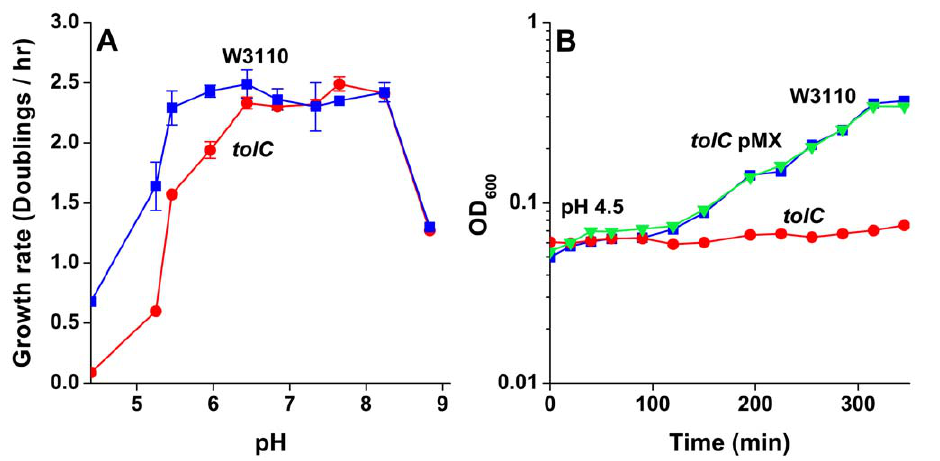
Figure 4. TolC is required for acid growth. A ) Strains were grown from pH 4.5–pH 9.0 using the appropriate buffer in half unit increments at 37 u C. W3110 (blue) and tolC :: kan (red) growth rates calculated in early log-phase (OD 600 0.1 to 0.3) are depicted as a function of pH. B ) Successful complementation of the tolC strain with pMX, a low-copy plasmid that carries the functional tolC gene (green), in LBK at pH 4.5 (100 mM HOMOPIPES) restored the acid growth capability to that of the wild type W3110 (blue). Cultures were maintained as described in the Materials and Methods. Error bars=SEM (n=3) and absent when smaller than the symbol.